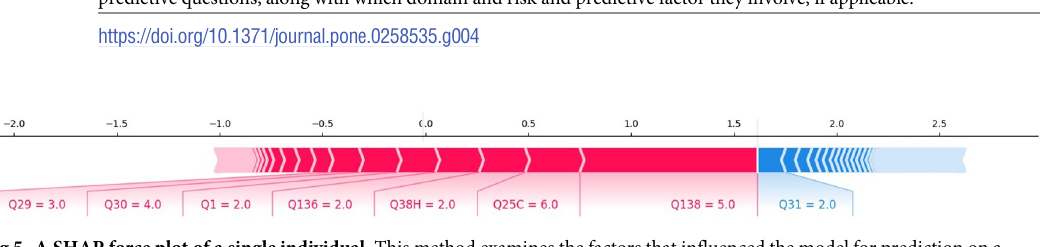
Fig 5. A SHAP force plot of a single individual. This method examines the factors that influenced the model for prediction on a single individual, showing questions that led the model to think they are more likely to have STB in red and questions that led the model to think they are less likely to have STB in blue. A decision boundary of more than zero indicates that the model predicts that they have STB. In this example, you can see that their answer to Q138 of 5 (frequent internet harassment), their answer to Q25C of 6 (early alcohol usage), and their answer to Q38H of 2 (violent activity) led the model to predict that they have STB. This allows for easy interpretability of the model’s results, making it more trustworthy and transparent.